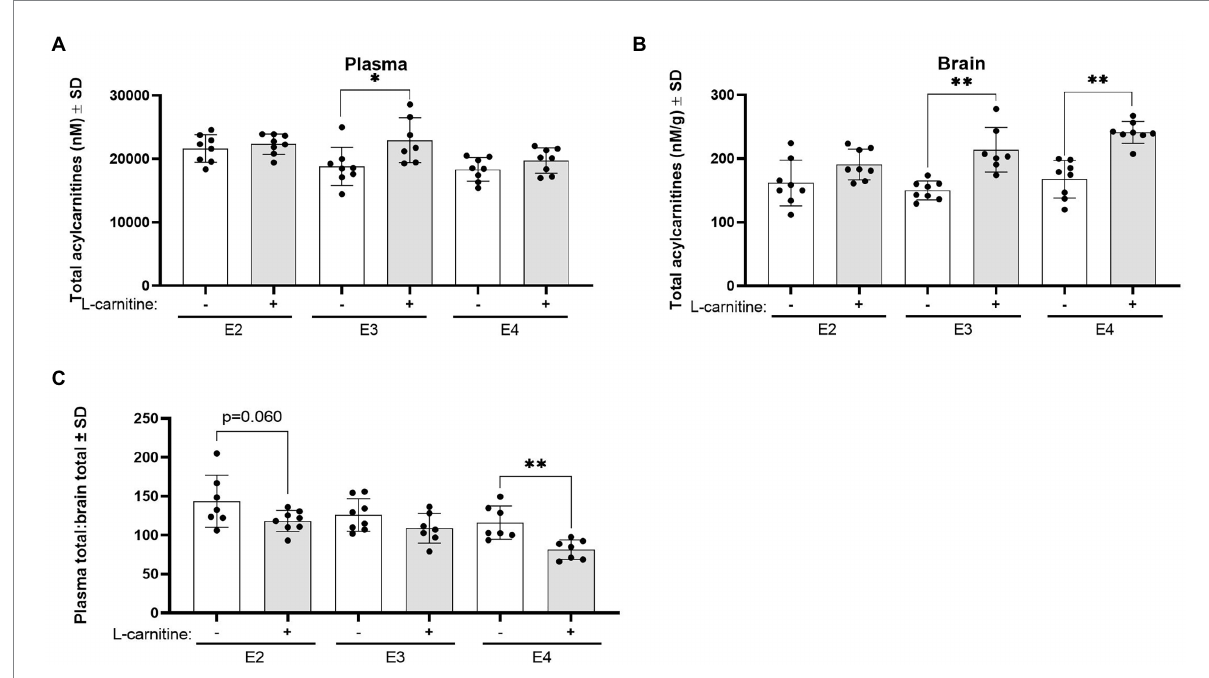
FIGURE 9 APOE genotype and L-carnitine challenge affect plasma total acylcarnitines to brain ratios. (A) Scatterplots with bar showing mean plasma concentration of total acylcarnitines in nM ± SD in vehicle and L-carnitine challenged mice in different APOE genotypes. (B) Scatterplots with bar showing mean brain concentration of total acylcarnitines in nM per gram of protein ± SD in vehicle and L-carnitine challenged mice in different APOE genotypes. (C) Scatterplots with bar showing mean plasma total acylcarnitines to brain total acylcarnitines ratio ± SD in vehicle and L-carnitine challenged mice in different APOE genotypes. Statistics: multiple comparisons with B-H correction, * p < 0.05, ** p < 0.01, *** p < 0.001. Numbers per group: E2/E2 (vehicle) n = 8, E2/E2 (L-carnitine) n = 8, E3/E3 (vehicle) n = 8, E3/E3 (L-carnitine) n = 7, E4/E4 (vehicle) n = 8, E4/E4 (L-carnitine) n =